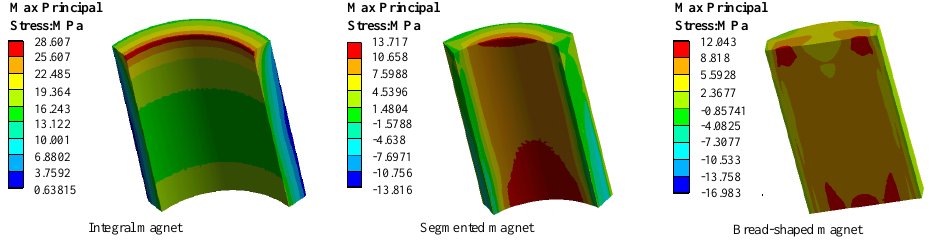
Figure 4. Comparison of maximum principal stress on the PM of different SPM rotor structures.